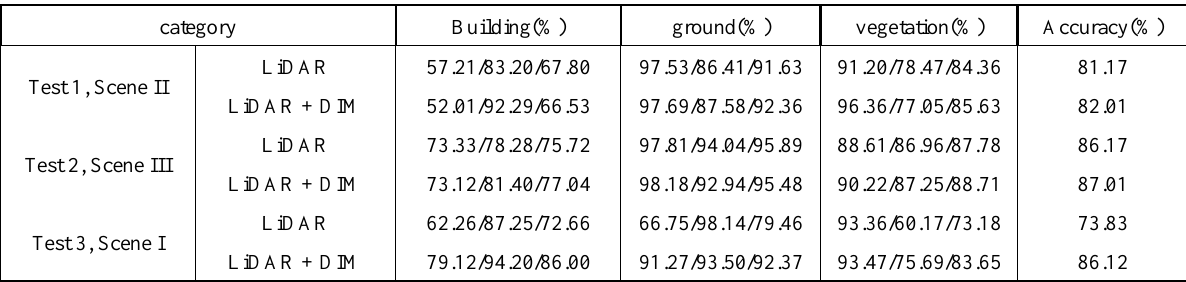
Table 3. precision/recall/F1score and accuracy of both using the LiDAR points and both LiDAR points and DIM points based on the point-based